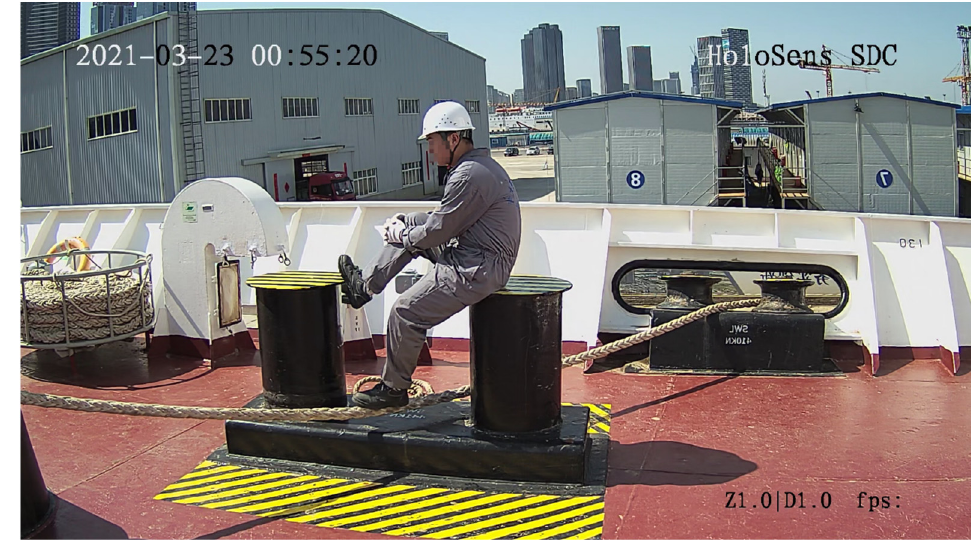
Figure 3. Unsafe behavior of having a rest on board.